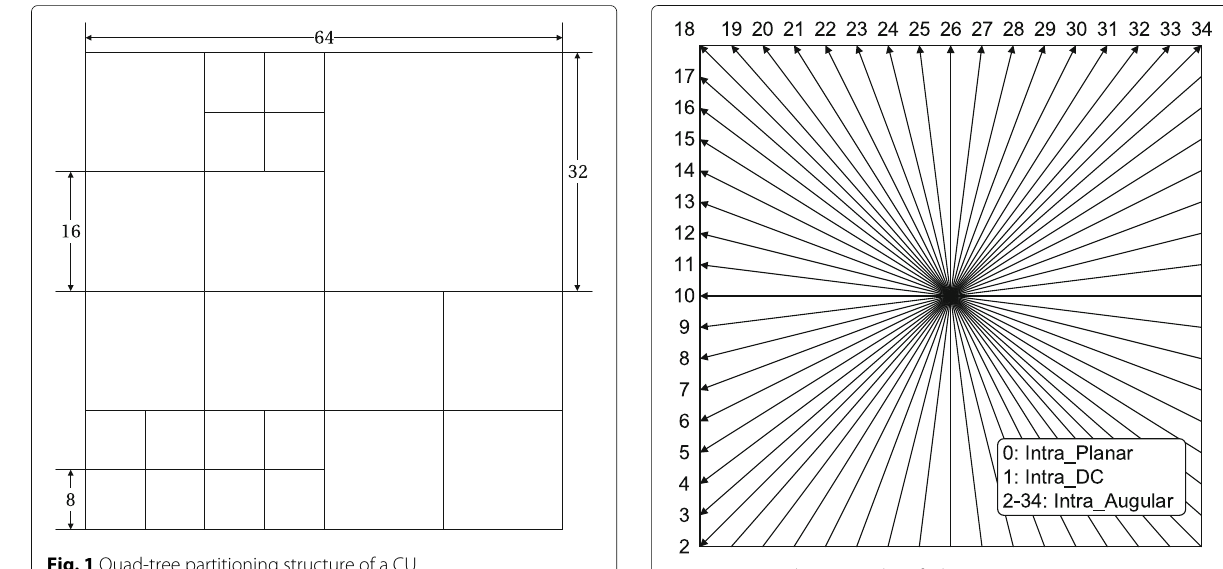
where HCOST MODE represents the Hadamard cost; SATD MODE indicates the sum of absolute Hadamard ˜ R MODE is the estimated transformed differences (SATD); bit consumption; λ denotes the Lagrangian multiplier; ω k represents an original PU at time k and ˜ ω k is the